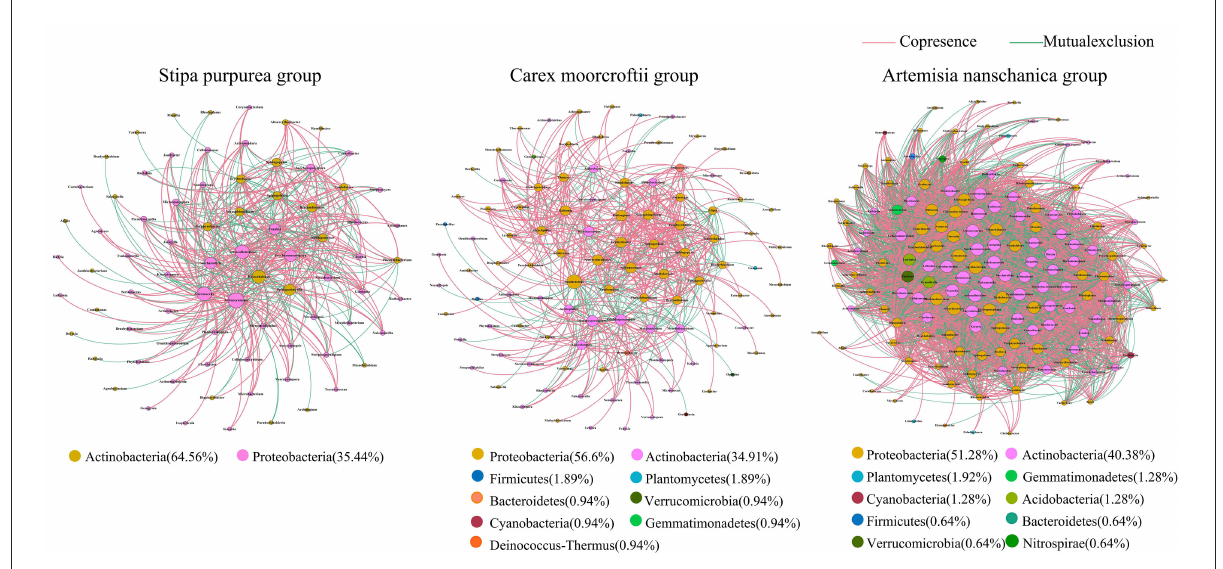
FIGURE7 Relationship network of rhizosphere soil microbial communities among different plants. The size of nodes in the figure is proportional to the degree of network nodes, and nodes are colored according to different phyla. The color of the edge between the node and the node shows the interaction between species: red indicates a positive relationship, and green indicates a negative relationship. The width of the edge and the correlation coefficient |r| value are proportional.